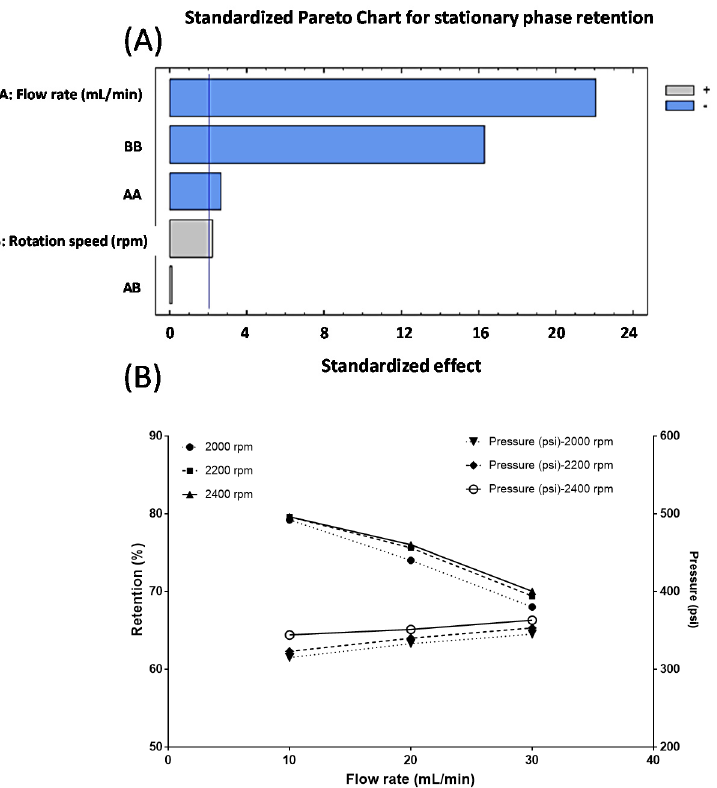
Figure 4. ( A ) Pareto chart showing the standardized effect of independent variables on the stationary phase retention response. ( B ) Effect of flow rate and rotation speed on stationary phase reten- tion and backpressure.